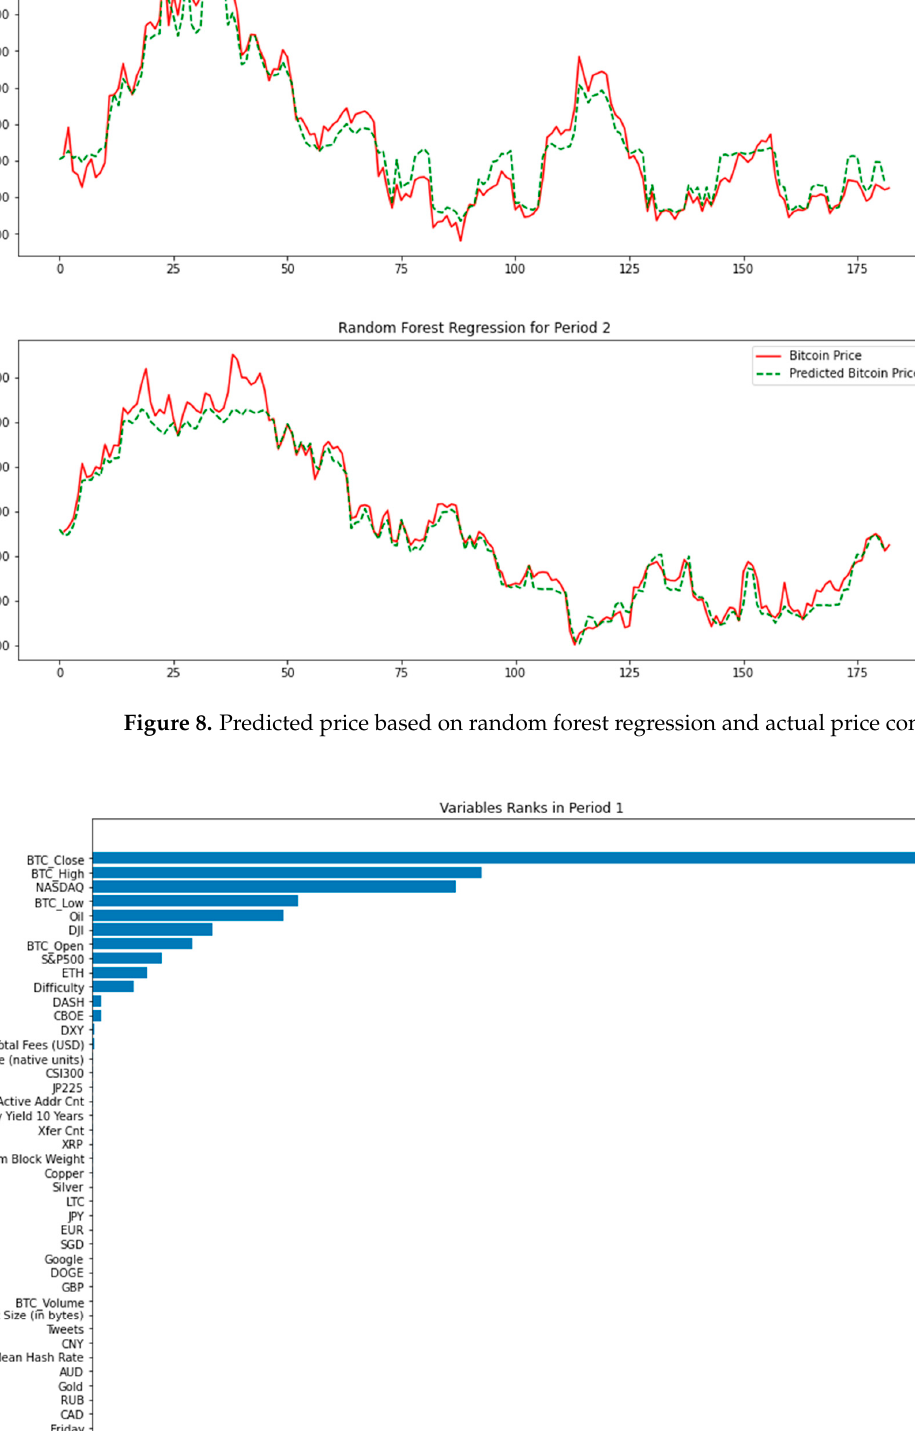
Figure 8. Predicted price based on random forest regression and actual price comparison. Table 4. Error results for random forest regression.